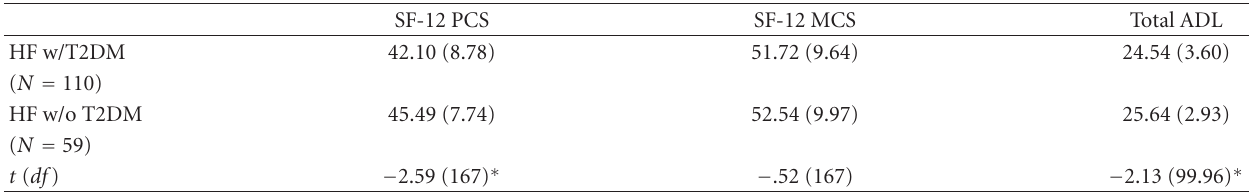
Table 4: Means and standard deviations of psychosocial outcomes among older heart failure adults with and without type 2 diabetes mellitus. SF-12